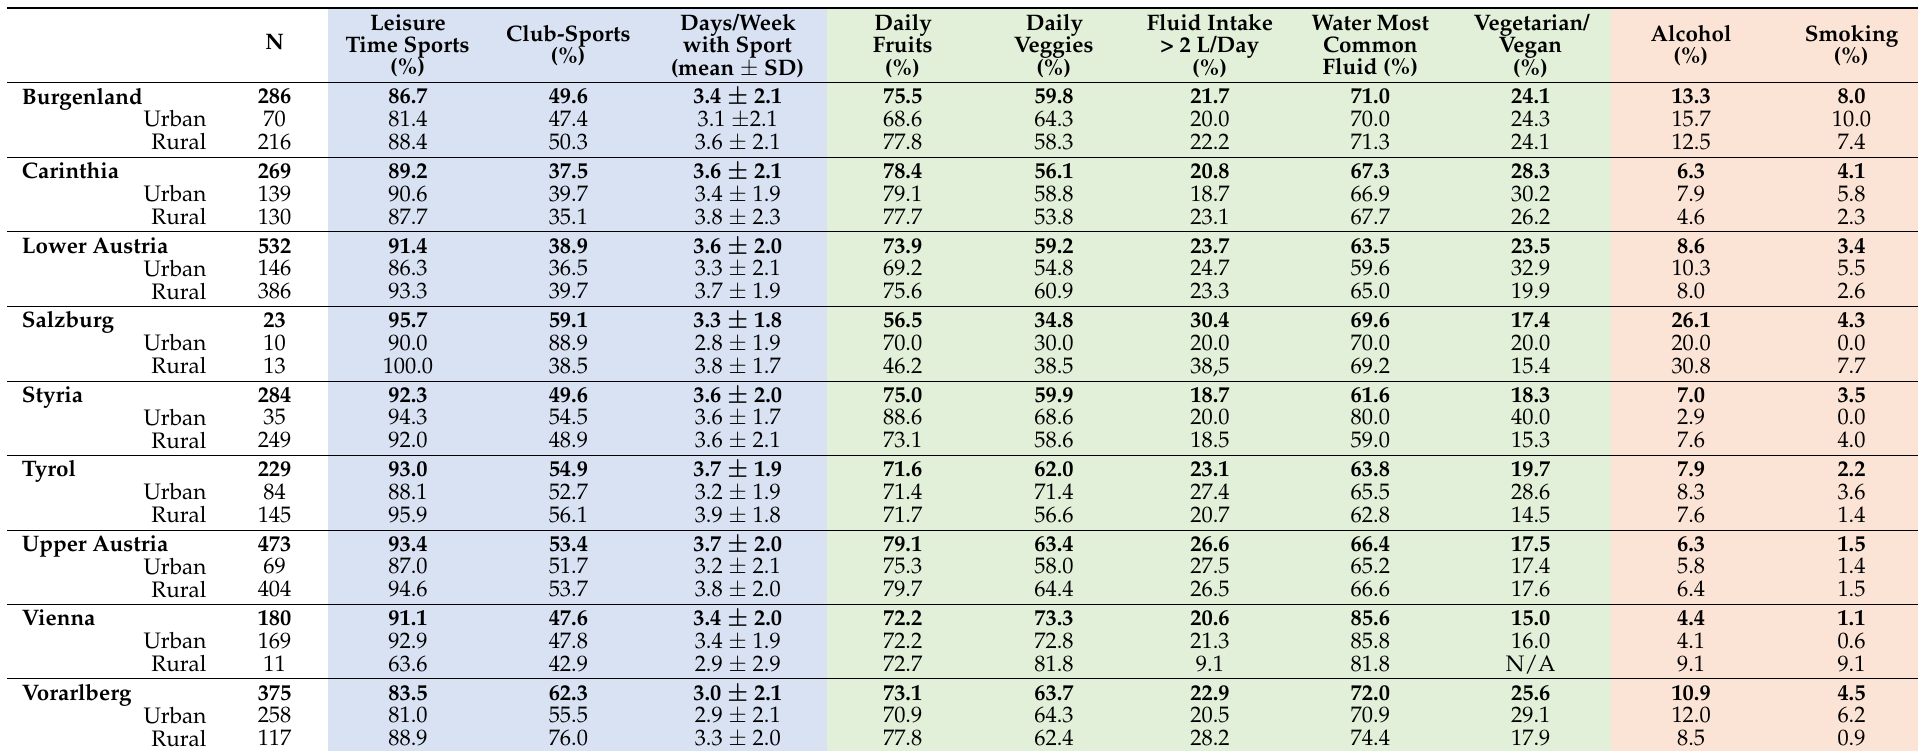
Table A3. Health behavior by federal state and living area in secondary level I students. Values are in prevalences (%) as well as means ± SD for days with